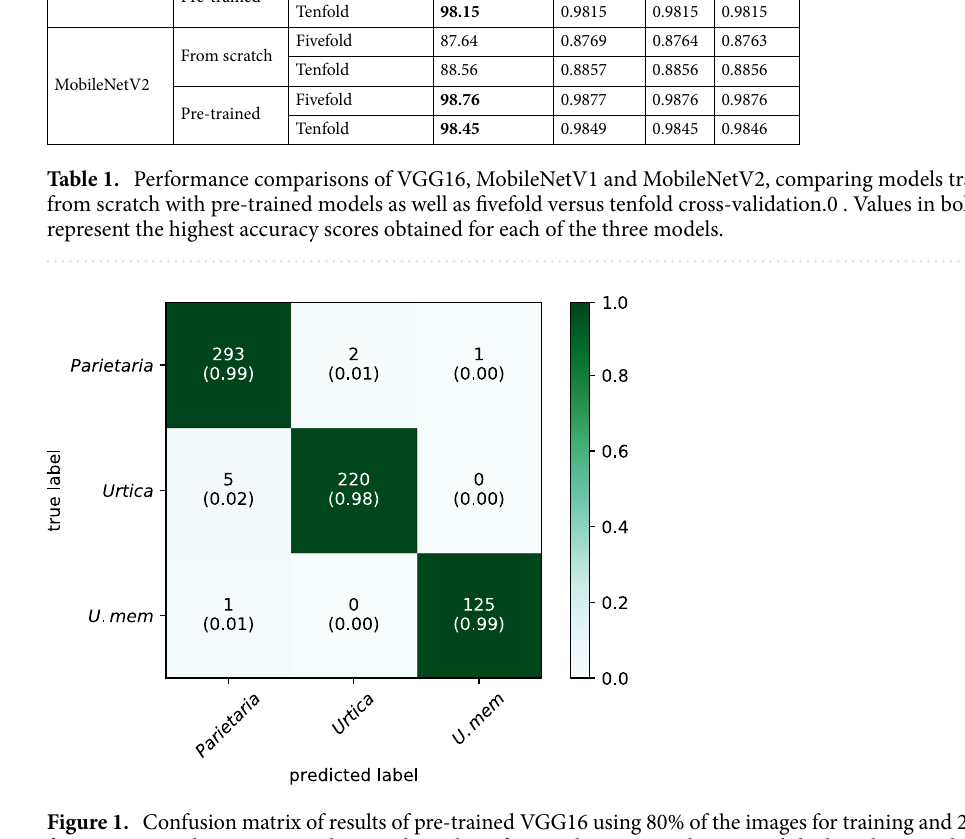
Figure 1. Confusion matrix of results of pre-trained VGG16 using 80% of the images for training and 20% for testing. Numbers represent the actual number of correctly recognized images while those between brackets represent the ratio of correctly classified images. U.mem = Urtica membranacea